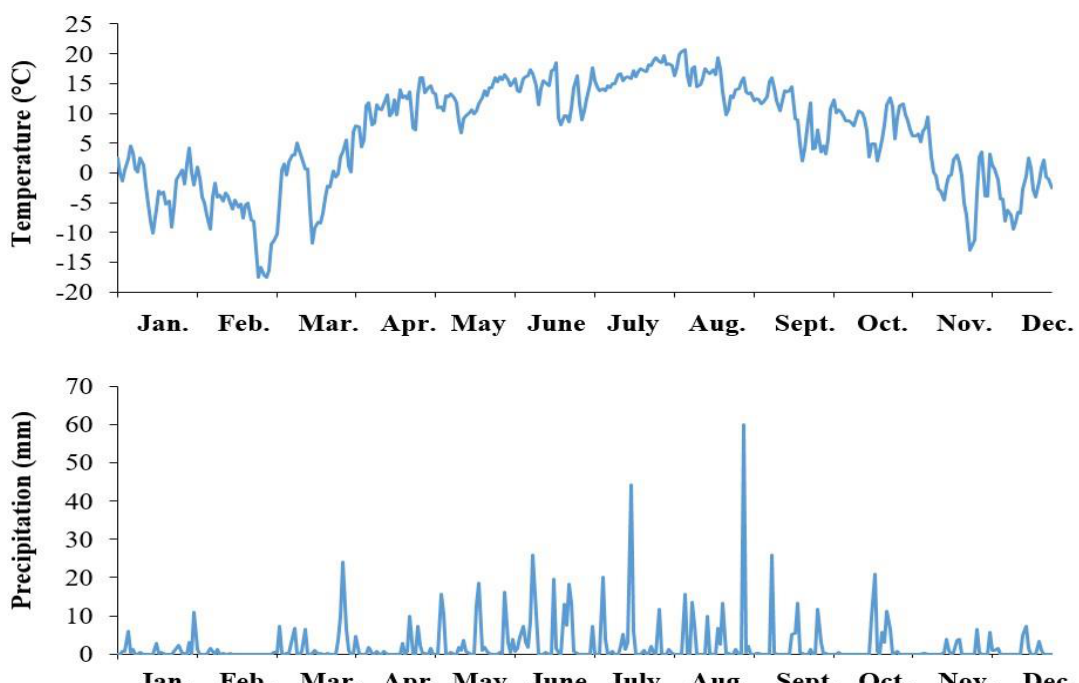
Figure 3. Temperature (°C) and precipitation variability (mm) per year 2018. The rainfall data were collected using an automatic meteorological station installed in the central part of the study area.